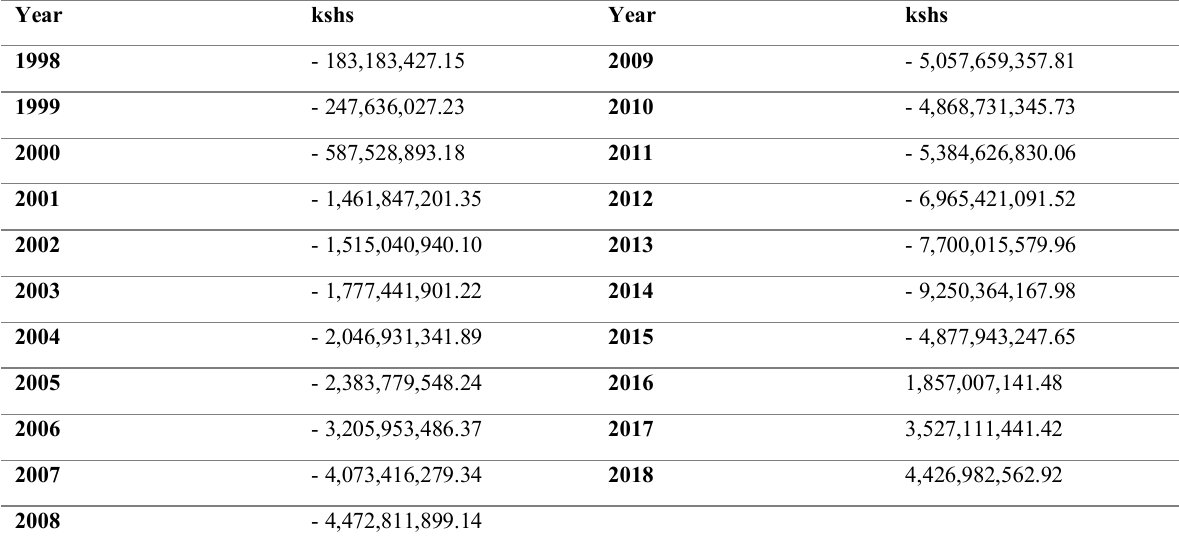
Table 2: Capital flight in Kenya 1998-2018